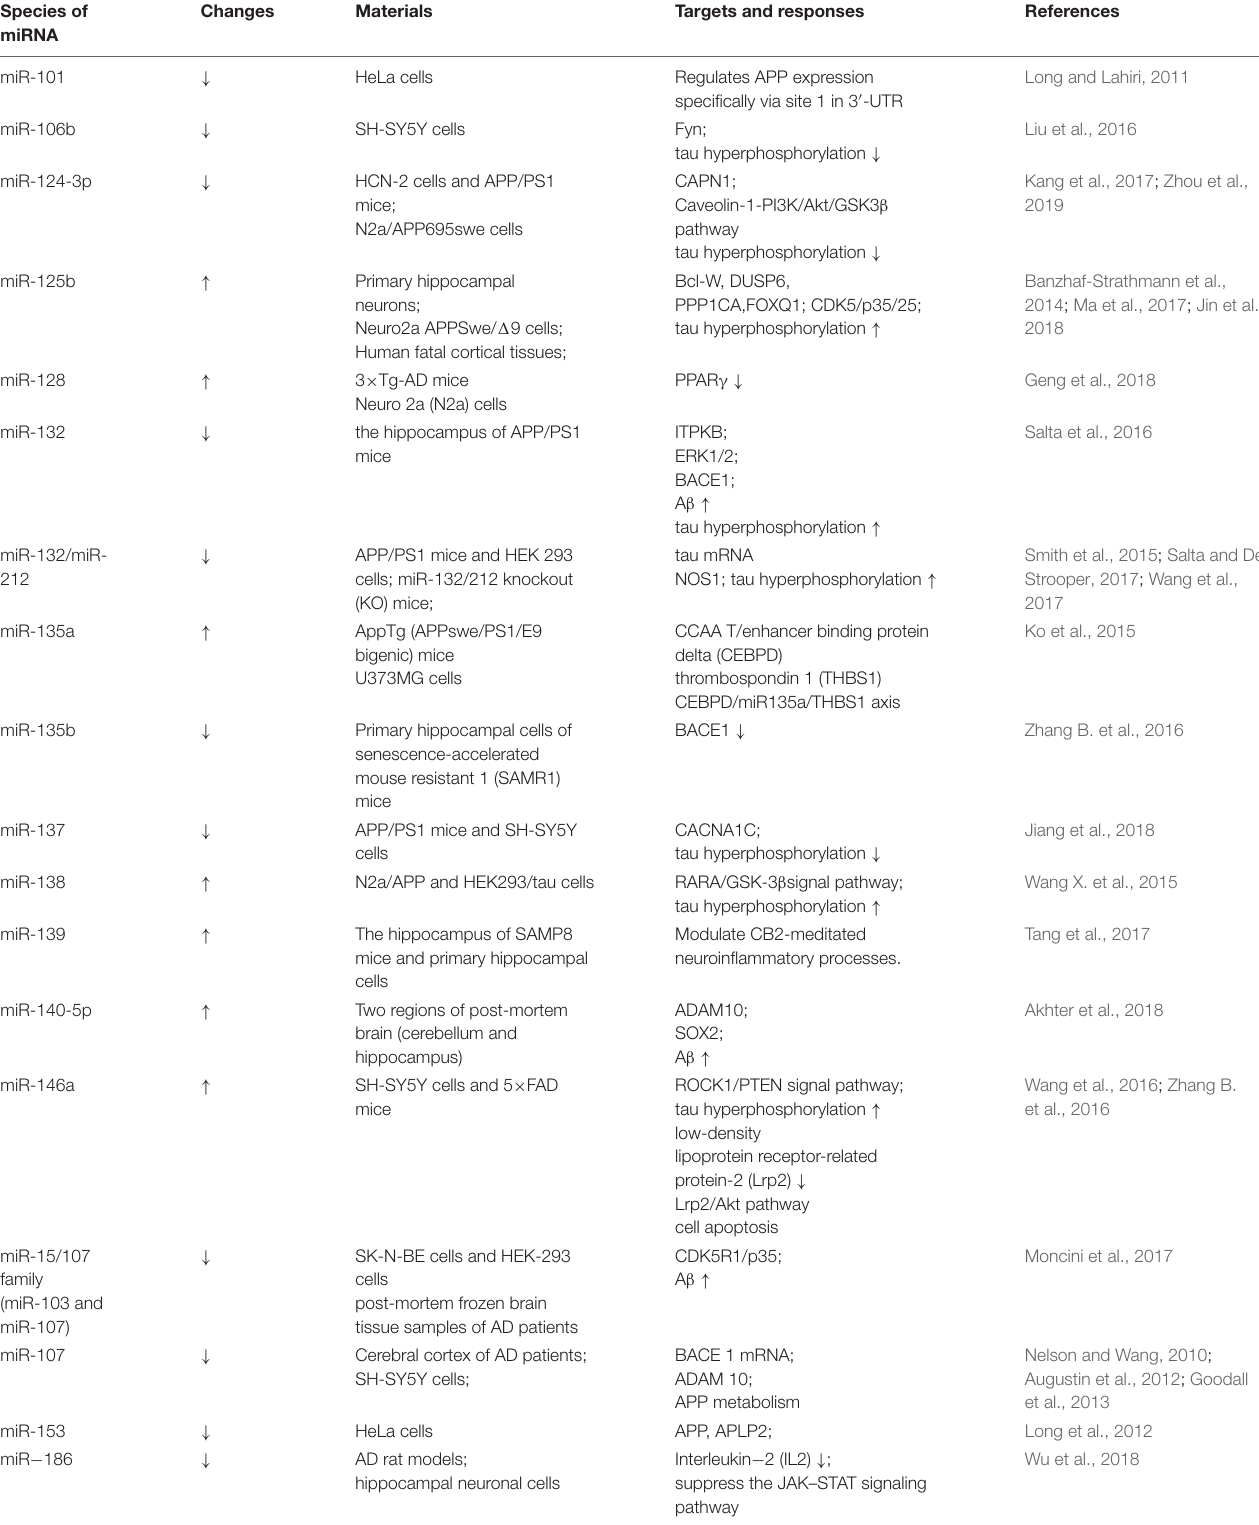
TABLE 1 | Mysregulation of miRNAs in